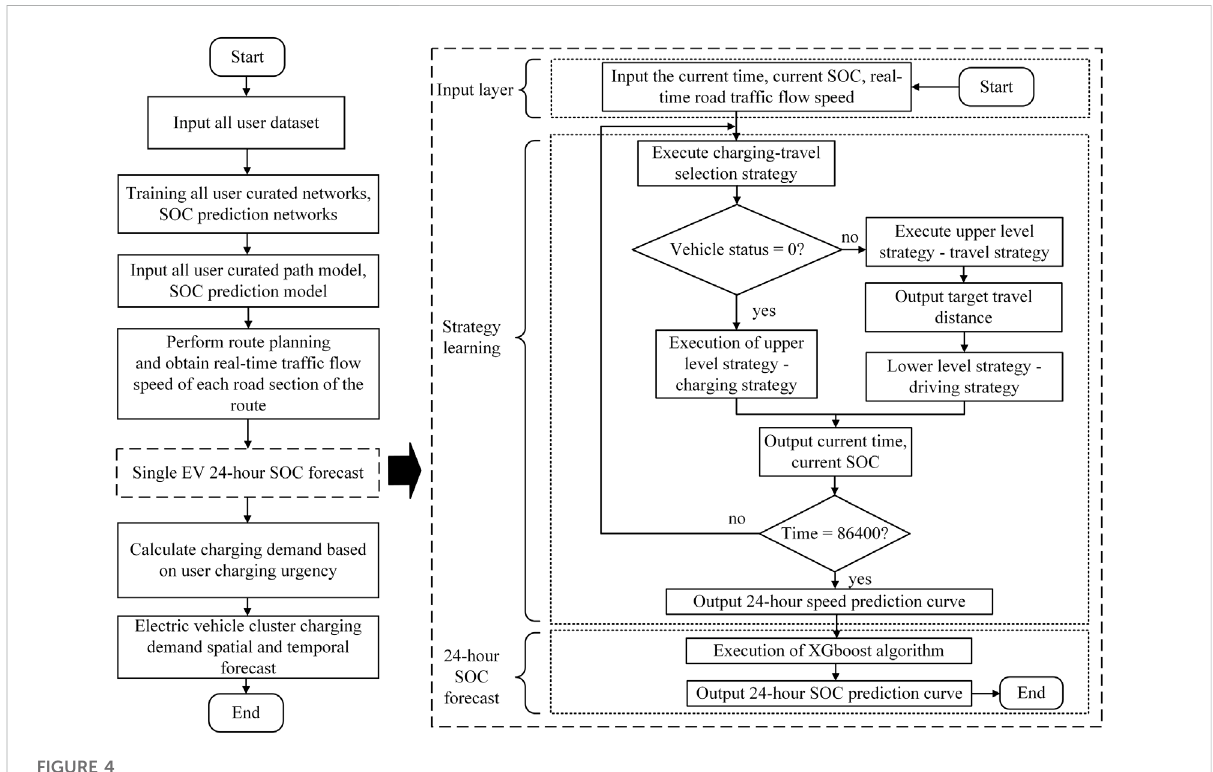
FIGURE 4 Flow chart of EV cluster charging demand spatial and temporal